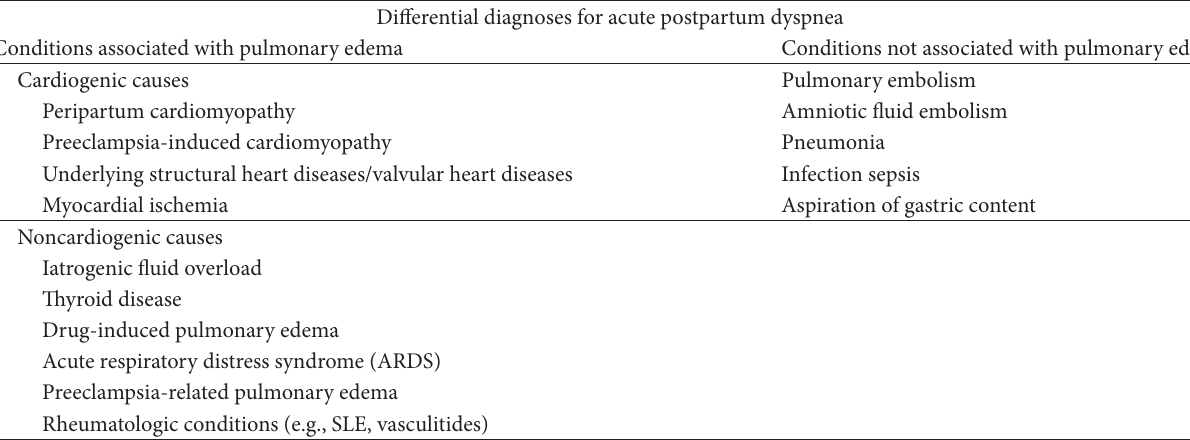
Table 1: Examples of differential diagnoses for acute postpartum